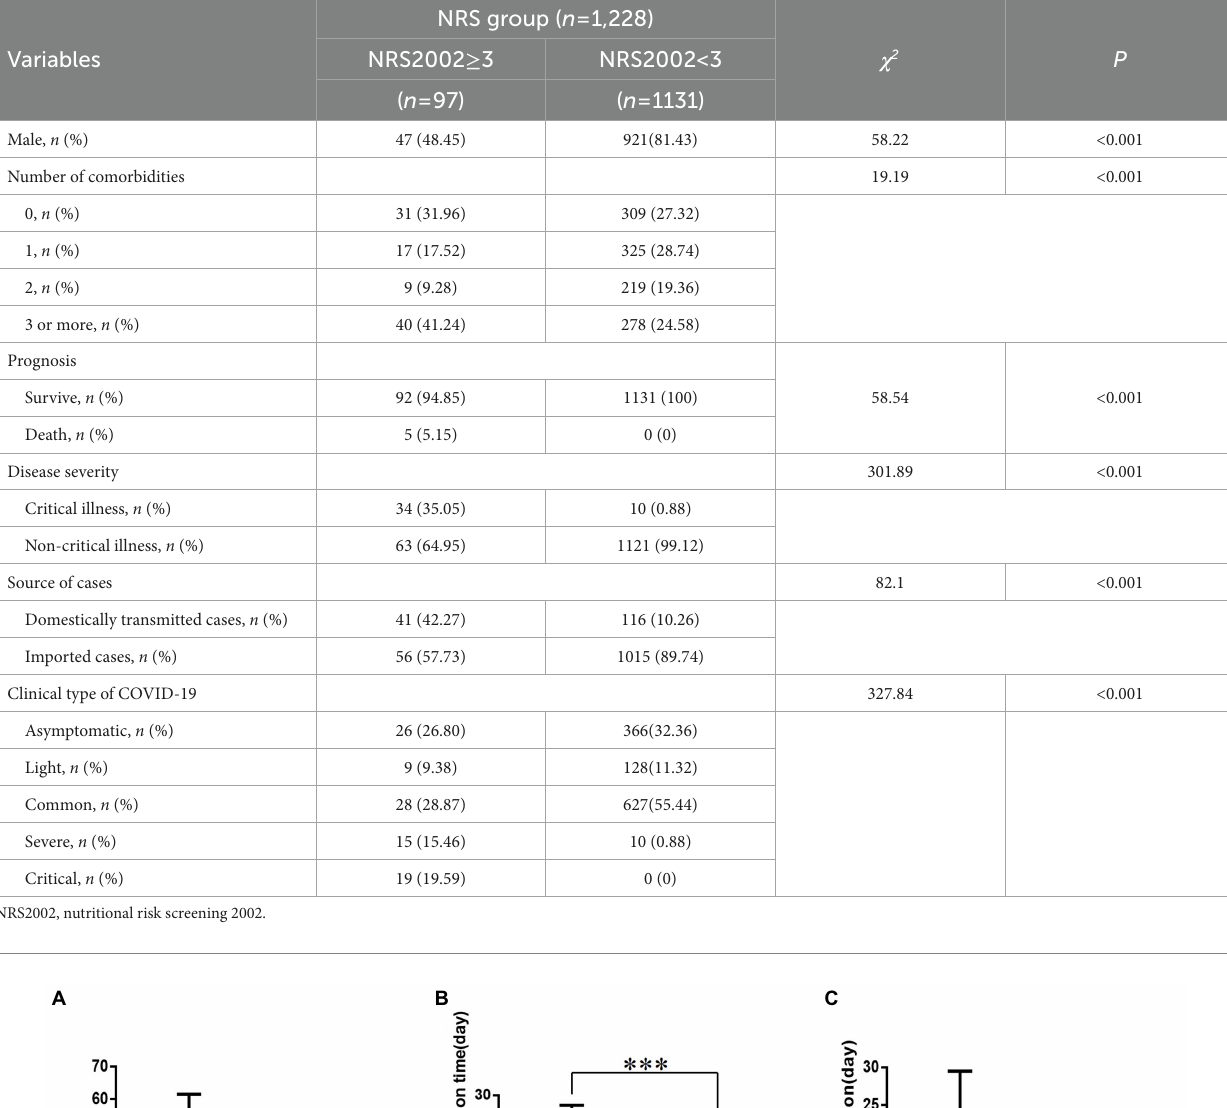
TABLE 2 Comparison of baseline conditions between two groups ( n =